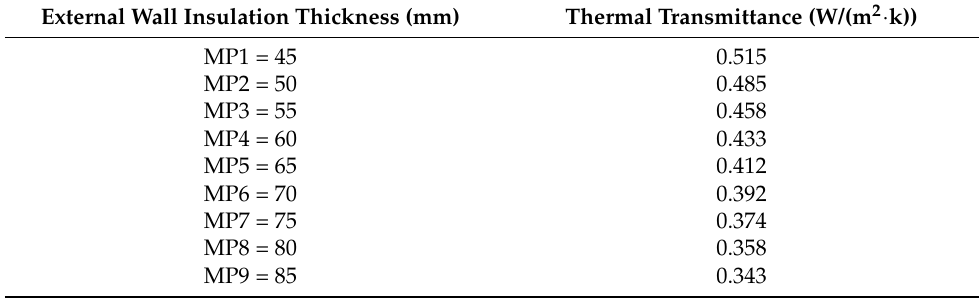
Table 2. Modification parameter design plan (MP)—External wall insulation thickness.